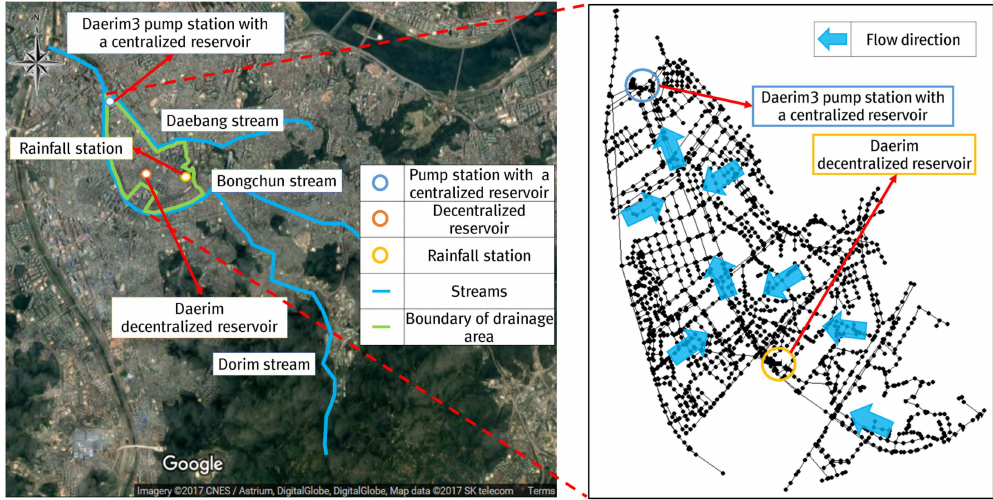
Figure 5. Information on the UDS used in the target watershed (Imagery © 2019 CNES / Airbus, DigitalGlobe, Landsat / Copernicus, NSPO 2019 / Spot Image, Map data © SK